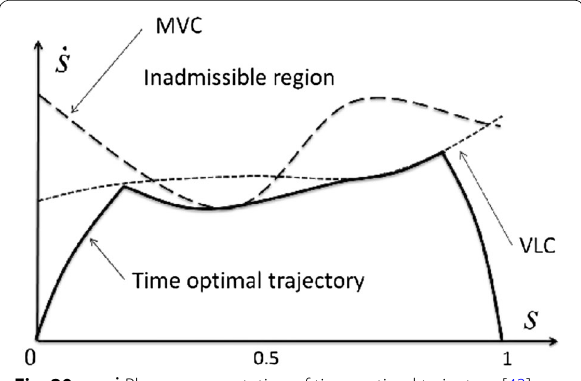
Fig. 20 s − ˙ s Plane representation of time optimal trajectory